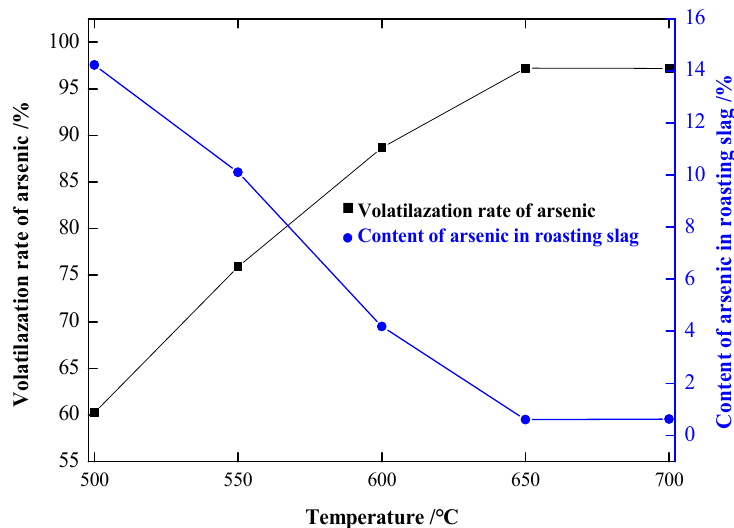
Figure 5. Influence of temperature on the experimental results.